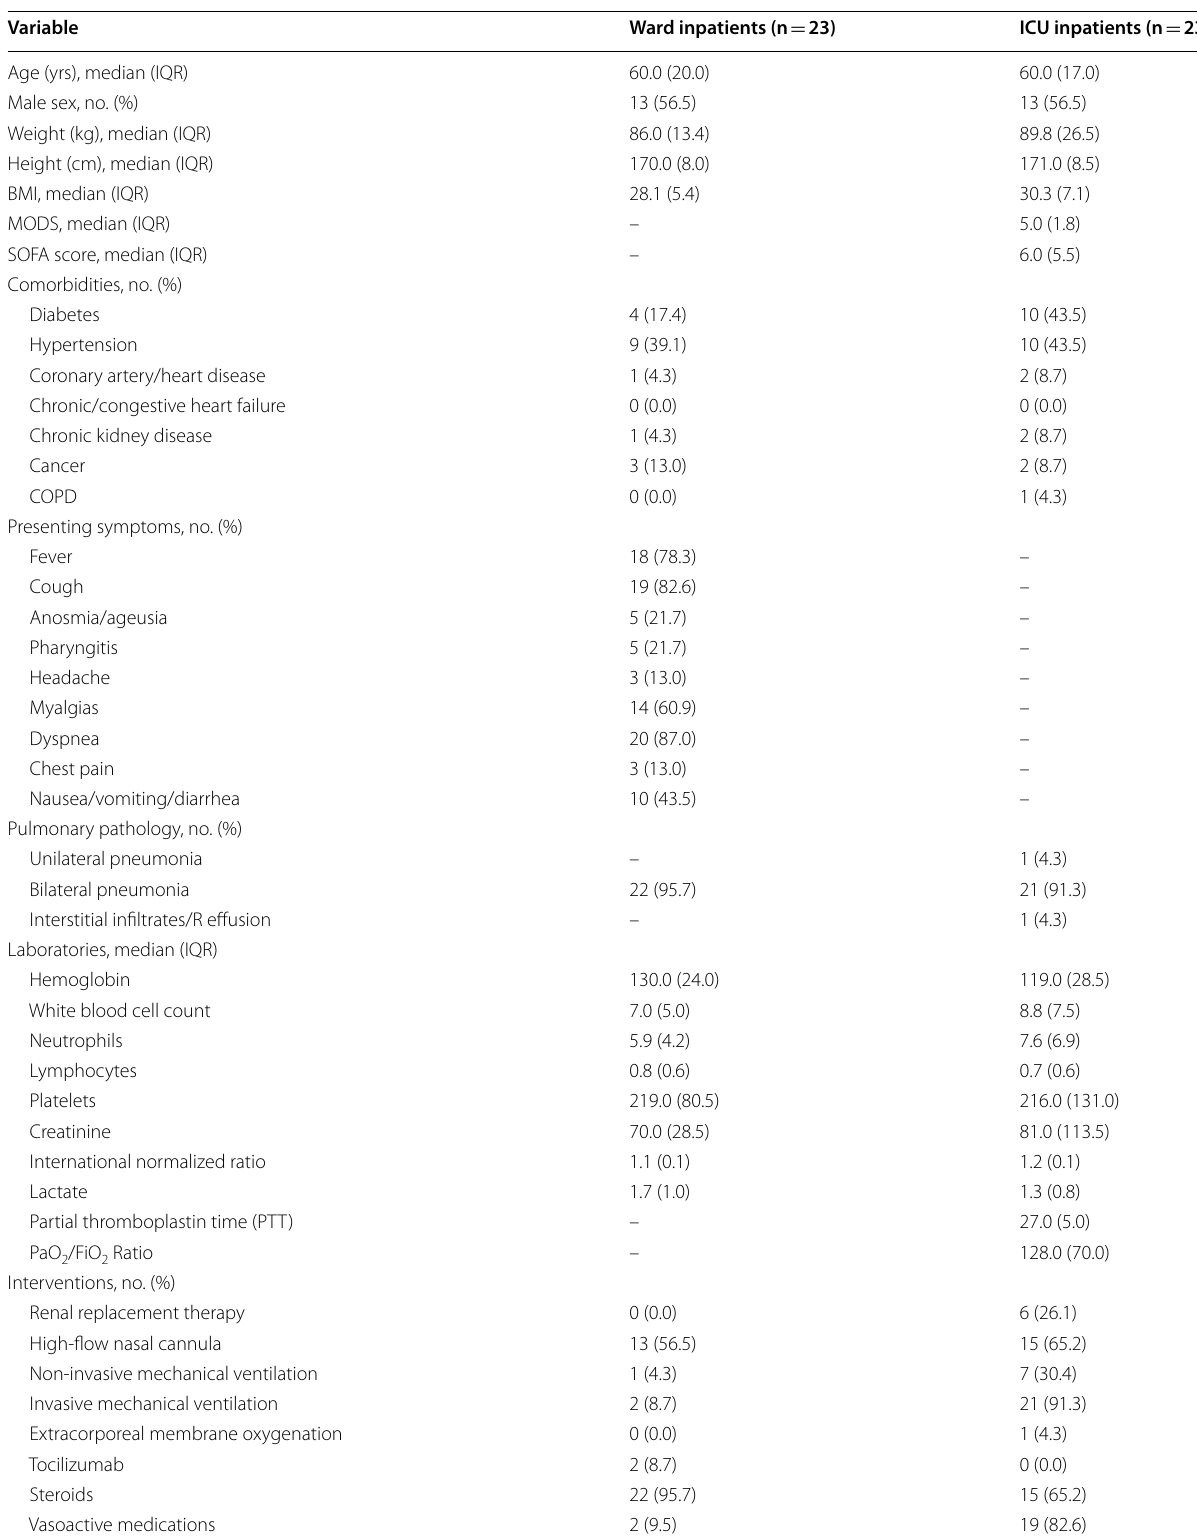
Table 2 Acutely ill COVID-19 inpatient demographics and clinical data